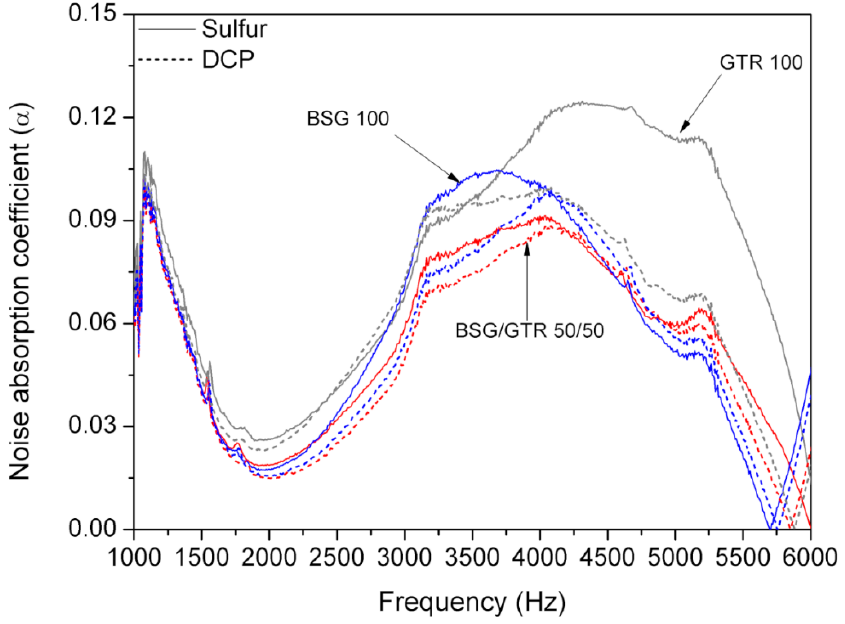
Figure 8. Sound absorption coefficient as a function of frequency for NR/BSG/GTR biocomposites.